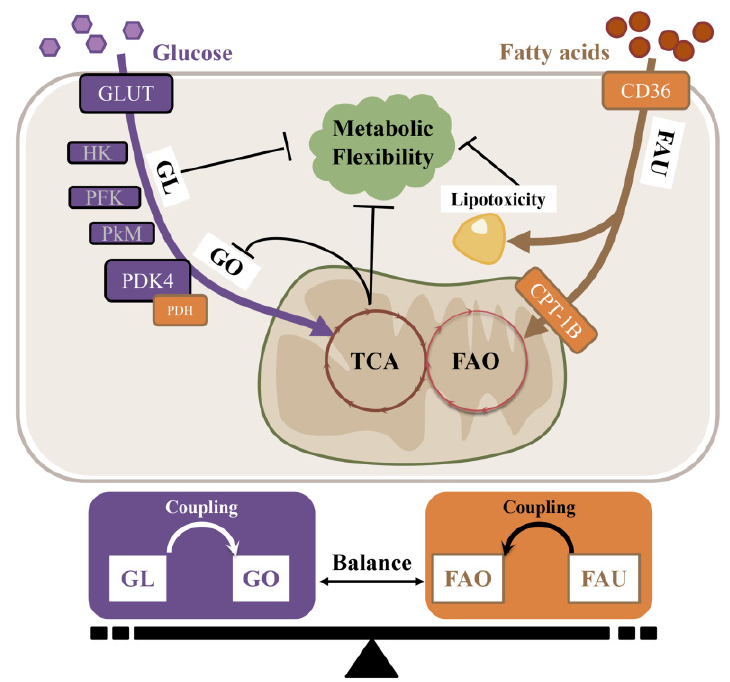
Figure 3. The substrate-metabolism mechanism underlying metabolic inflexibility. GL, Glycolysis; GO, Glucose oxidation; FAO, Fatty acid oxidation; FAU, Fatty acid uptake.